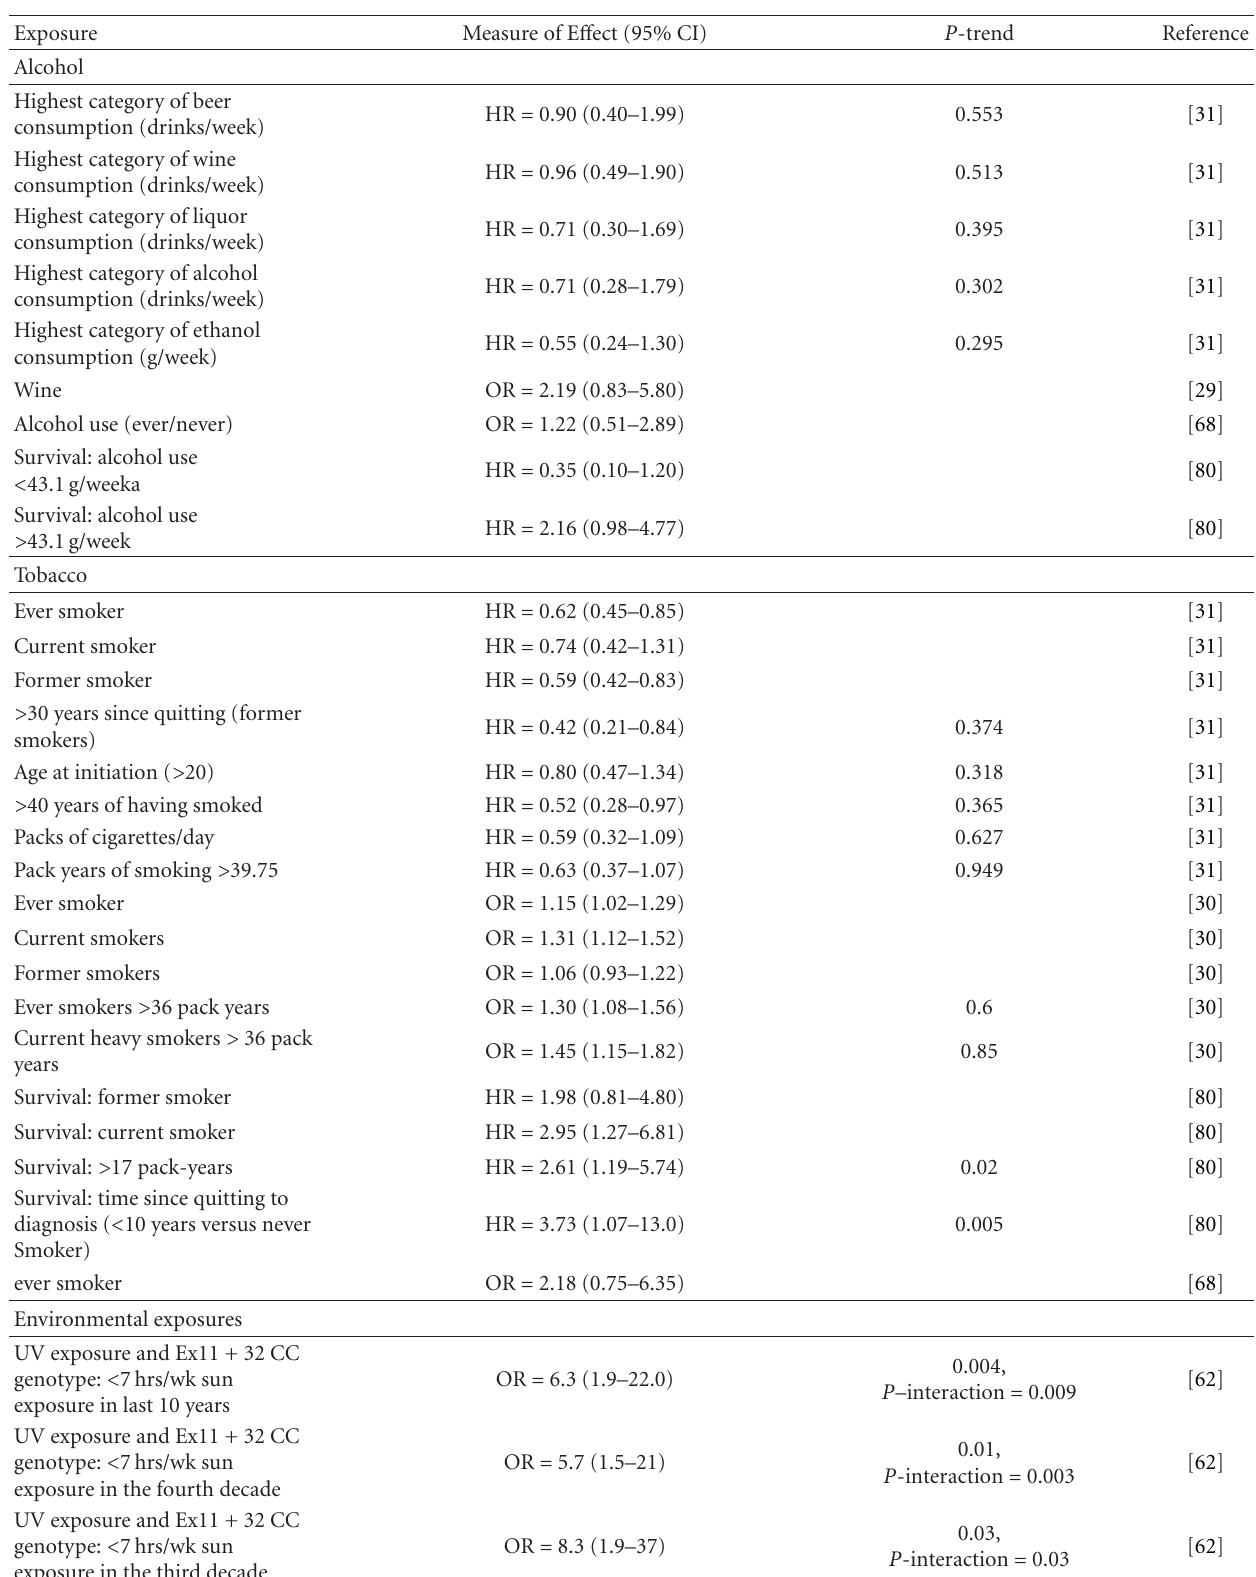
Table 4: Environmental and lifestyle exposures associated with follicular